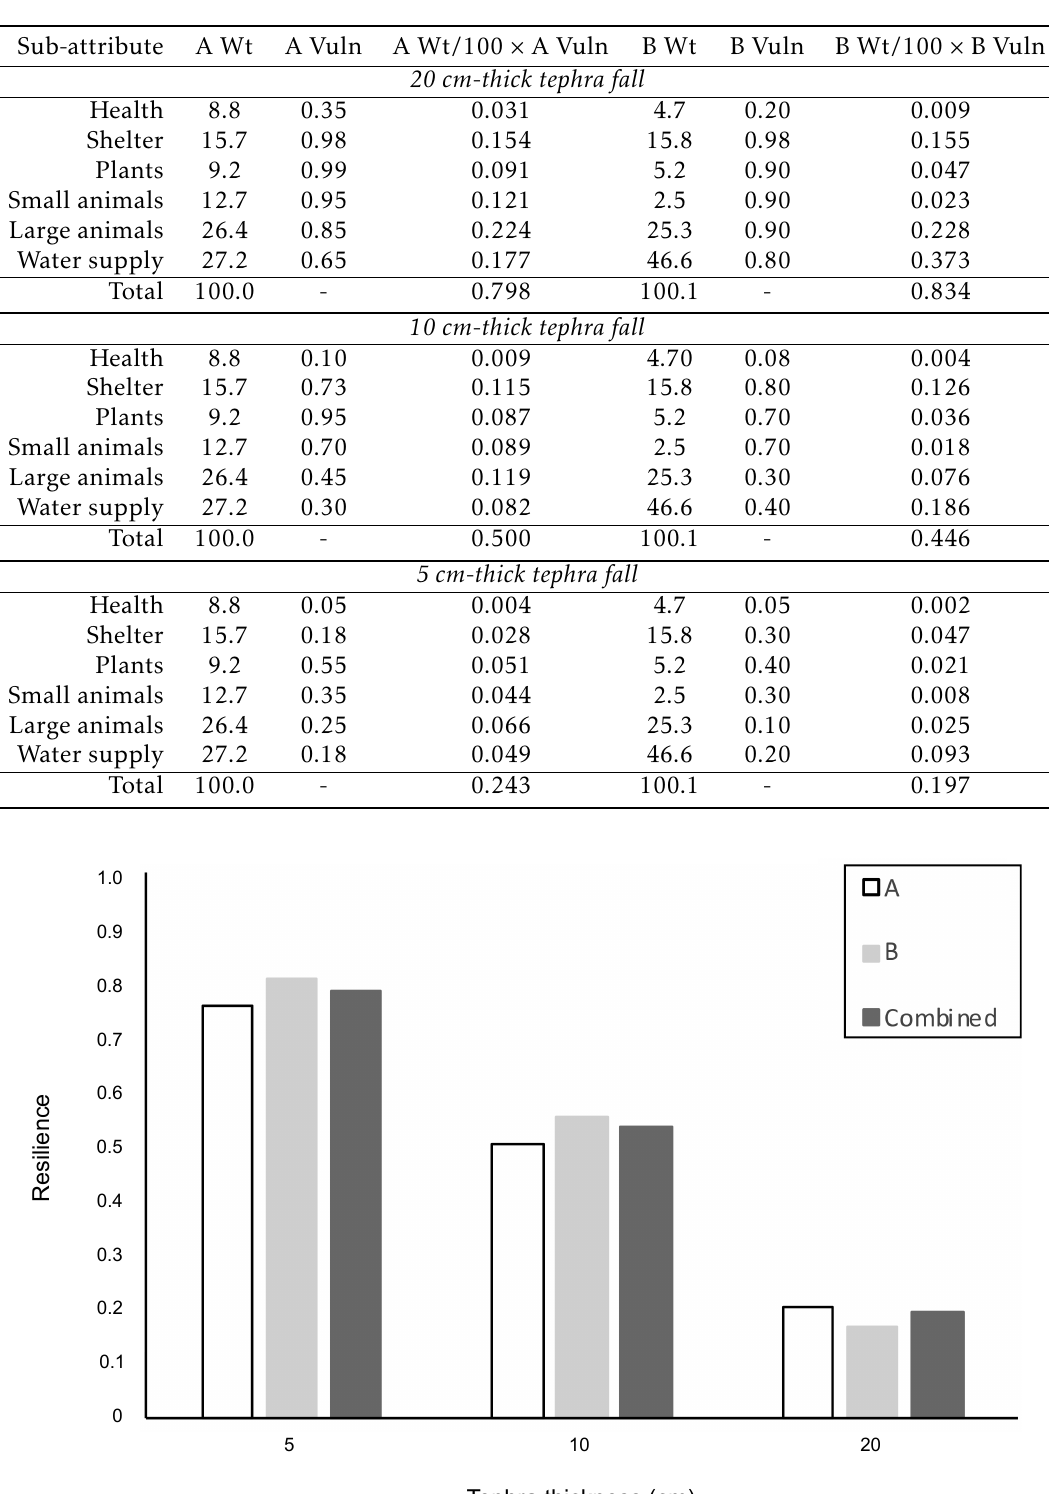
Table 3 – The weights (%) given to each of the 13 resilience sub-attributes by Participants A and B using the BPMSG AHP program.